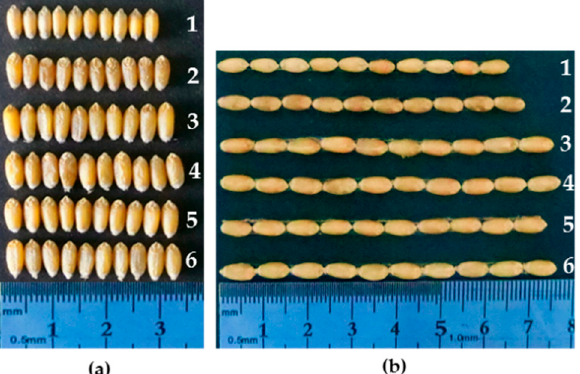
Figure 7. Morphologies of ( a ) grain width and ( b ) grain length. 1, Fukuhokomugi; 2, 4844-12; 3,